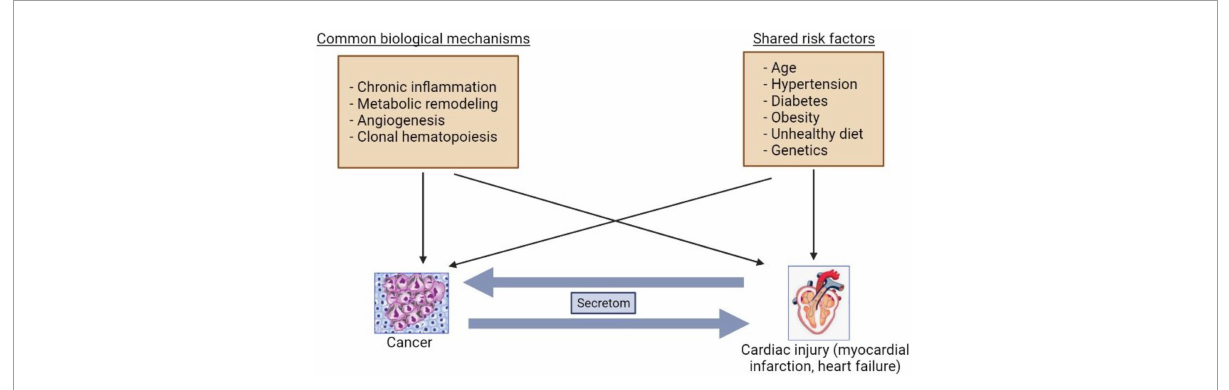
FIGURE1 Bilateral interactions between cancer and heart failure. The common mechanisms and risk factors are involved in cancer and heart failure development. The secretoms can be involved in communications between cancer and heart